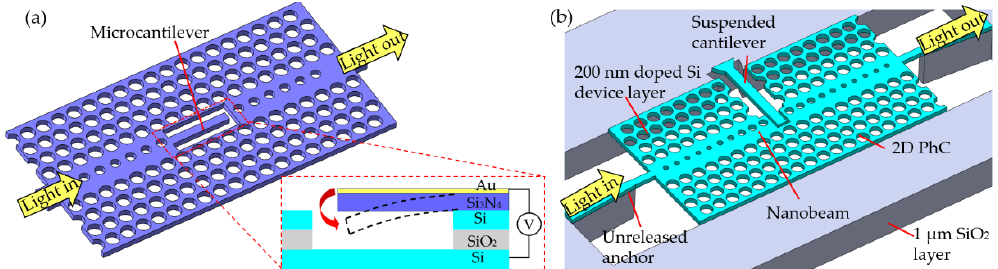
Figure 7. Schematics of the strain detection system based on cantilever-PhC cavity: ( a ) deflection of cantilever in the center of cavity (inset: the cross-section view for the electromechanical tuning) [77]; ( b ) cantilever inserted into a PhC nanobeam [78].